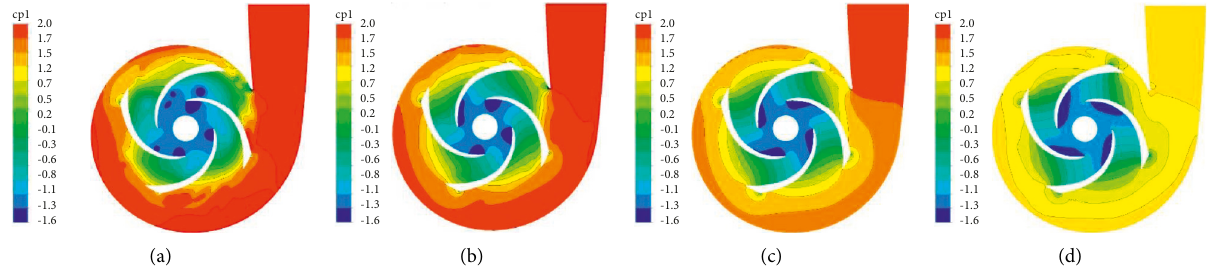
Figure 11: Pressure coefficient distributions on the center plane. (a) 0.4 Q